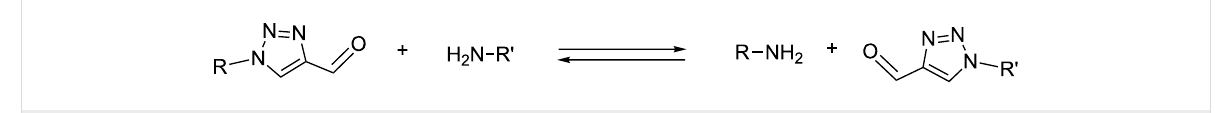
Figure 1: Conversion of 1-substituted-4-formyltriazole analogs via ring-degenerate rearrangement of 1-substituted-4-imino-1,2,3-triazoles as first de- scribed by L’abbé [42].